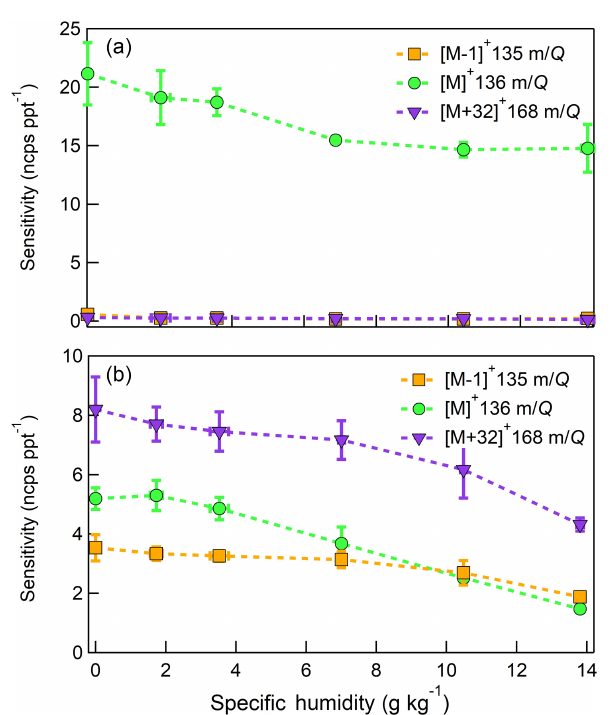
Figure 10. Humidity-dependent, normalized sensitivities to (a) α - pinene (b) D -limonene for all major product ions (C 10 H + , 16 136 m/Q , green circles), (C 10 H + , 135 m/Q , orange squares), and 15 (C 10 H 16 O + , 168 m/Q , purple triangles). Error bars represent the 2 standard deviation of the triplicate calibrations. All calibrations were performed in zero air.